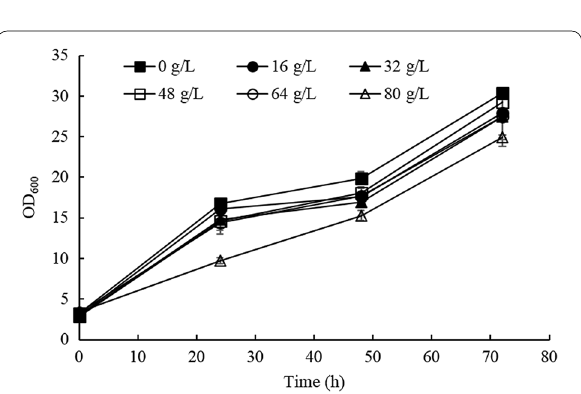
Fig. 3 Tolerance of wild-type P. pastoris strain for various concentrations of